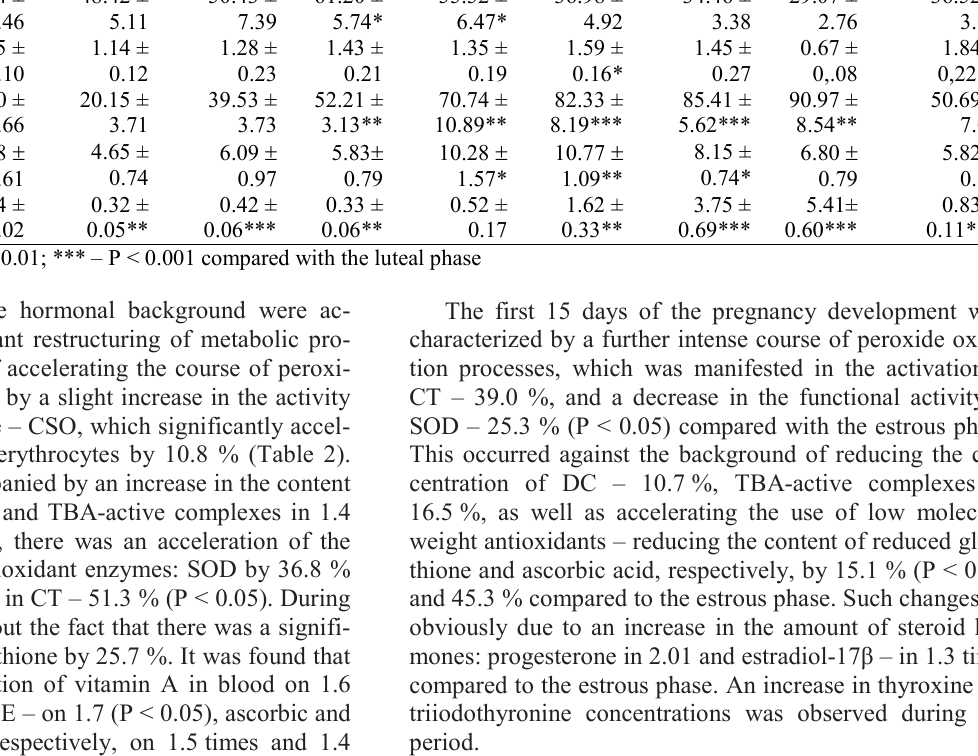
farrowing 15th 30th 60th 90th 104th 113th